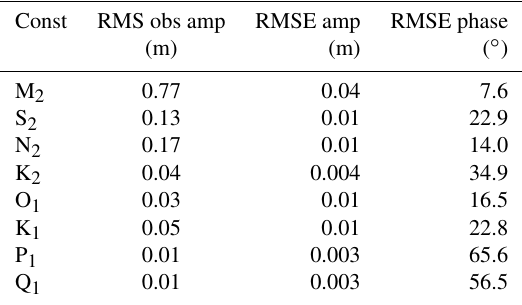
Table 6. Collected tidal amplitude and phase statistics at the 15 tide gauge stations. Root mean square (RMS) observed amplitude for the eight largest tidal constituents. RMSE in amplitude and phase between observations and the hindcast